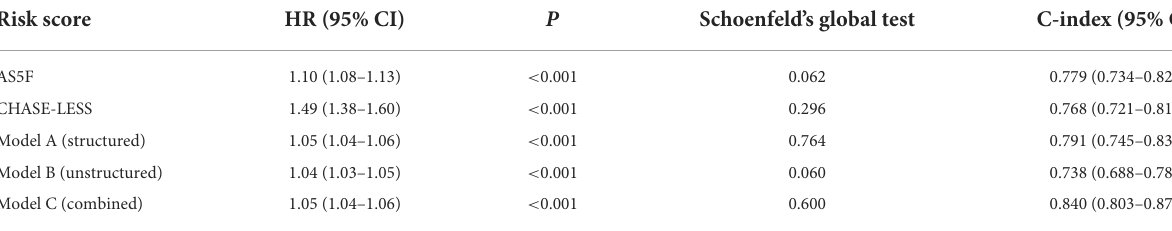
TABLE 2 Performance of prediction models for predicting newly detected atrial